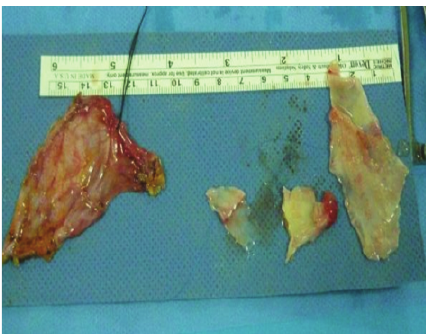
Figure 5: Macroscopic thick pericardial